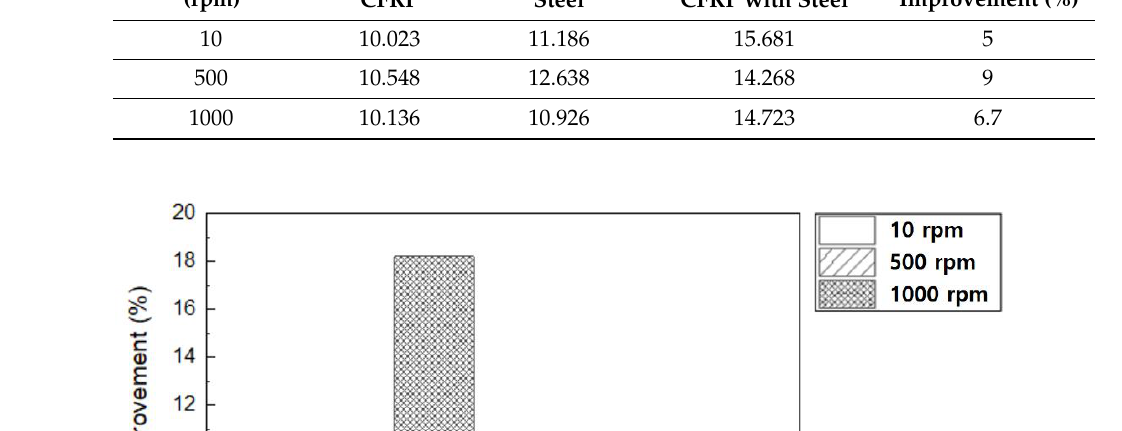
Table 8. Displacement of bearing part.